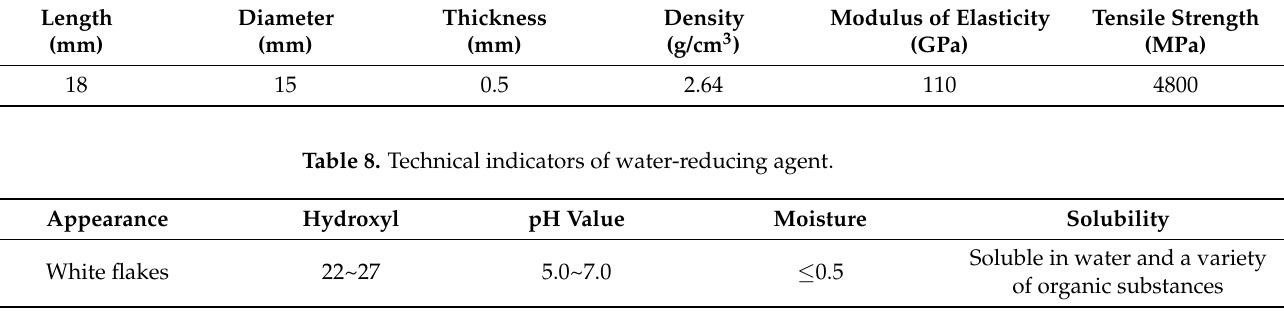
Table 7. Physical properties of basalt fiber.